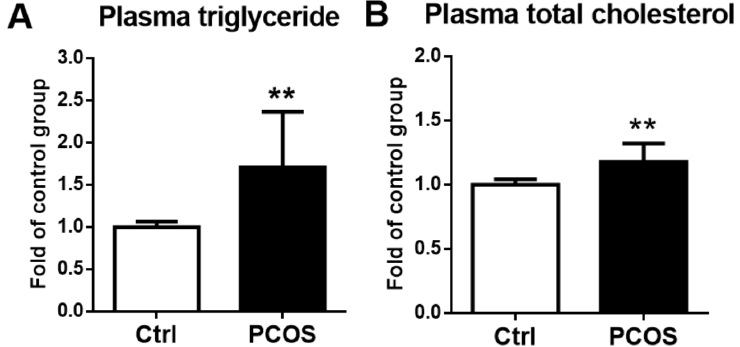
Figure 6. Plasma triglyceride ( A ) and total cholesterol ( B ) levels were significantly higher in the letrozole-treated mice. The results are expressed as the mean ± SD. ** p < 0.01, compared with the control mice.